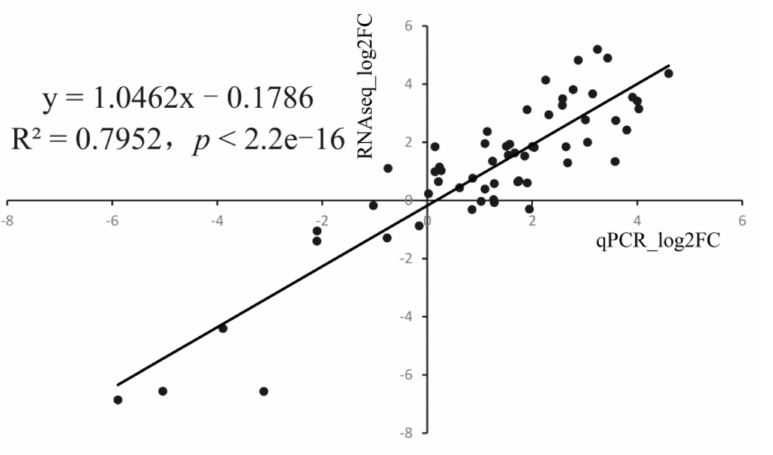
Figure 7. Correlation analysis of Quantitative real-time PCR (qRT-PCR) and RNA sequencing (RNA- seq)